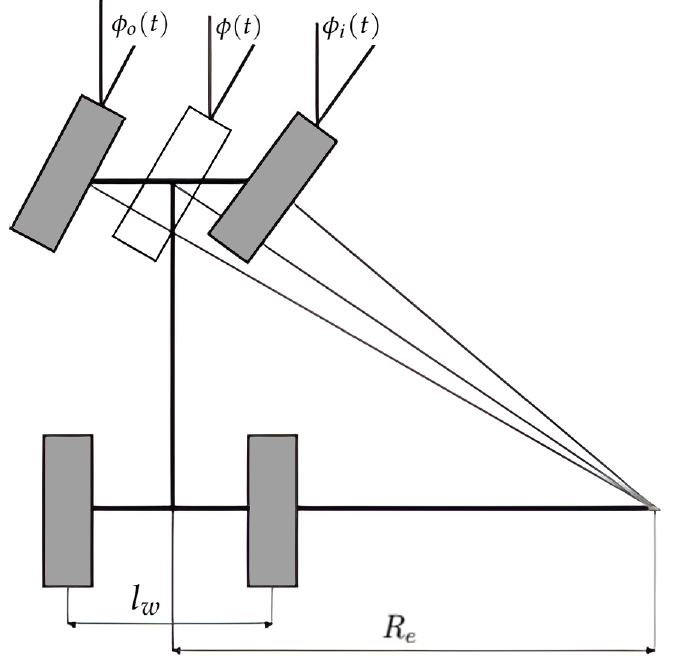
Figure 1. Ackermann steering